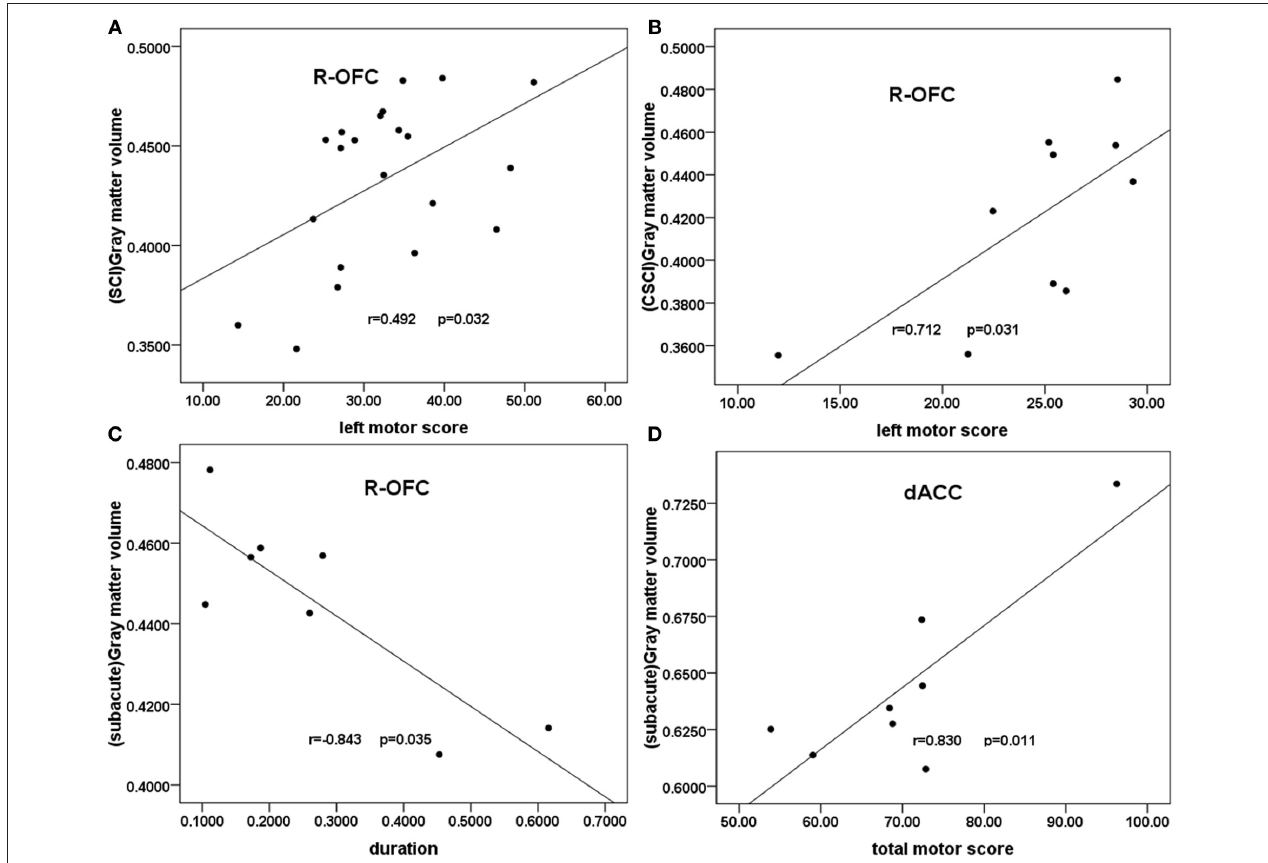
FIGURE 3 | Correlation between GMV and clinical scores in patients with SCI and the SCI subgroups. Partial correlation showed (A) a moderate positive correlation between the GMV of the right OFC and the clinical left motor scores in patients with SCI ( r = 0.492, p = 0.032); (B) a significant positive correlation between the right OFC GMV and the clinical left motor scores in the CSCI subgroup ( r = 0.712, p = 0.031); (C) a significant positive correlation between the dACC GMV and the total clinical motor scores in the sub-acute sub-group ( r = 0.830, p = 0.011); (D) a significant negative correlation between right OFC GMV and the injury duration in the sub-acute subgroup ( r = − 0.843, p = 0.035). R-OFG, right orbital frontal cortex; dACC, dorsal anterior cingulate cortex; GMV, gray matter volume; SCI, spinal cord